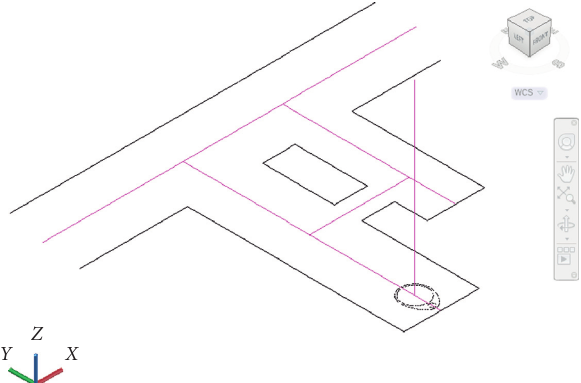
Figure 8: Definition of tunnel axis in Civil